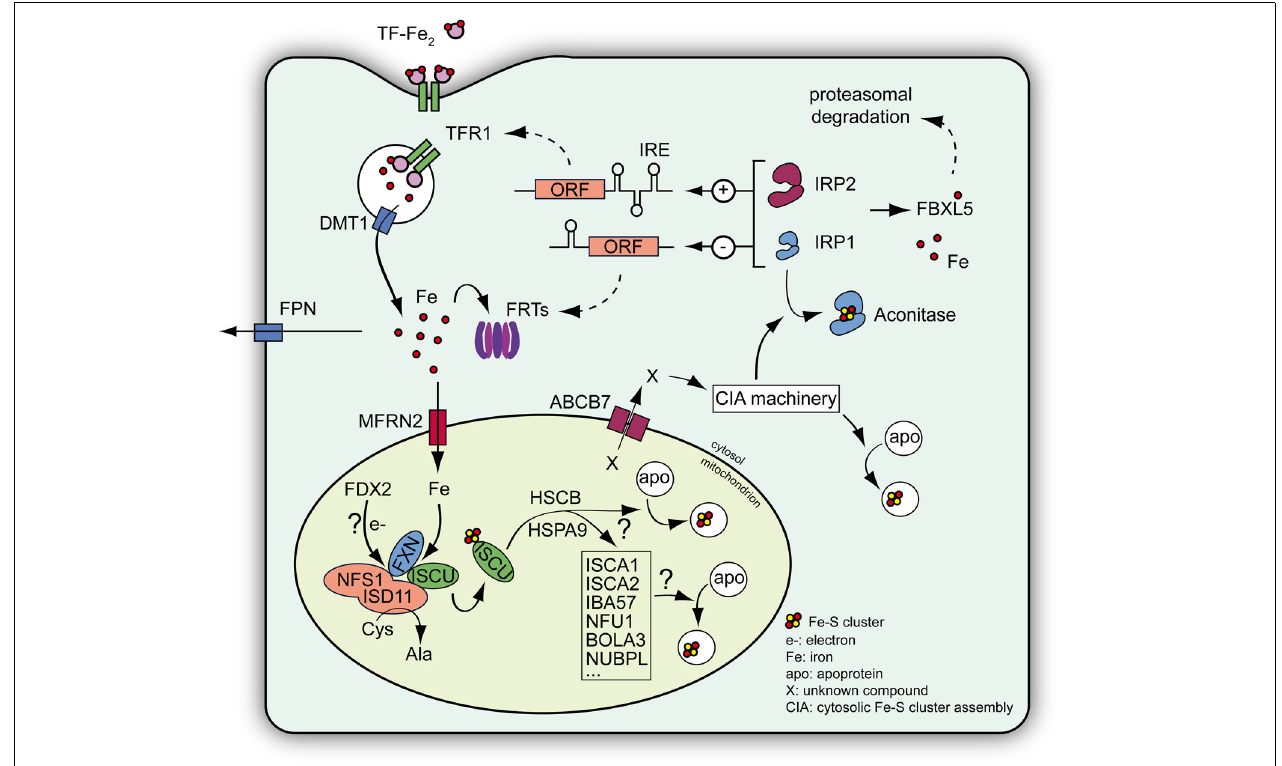
FIGURE 2 | Schematic view of the Fe-S cluster machinery and the IRP-mediated cellular iron regulation. De novo Fe-S cluster biogenesis occurs within mitochondria and involves assembly of inorganic sulfur and iron on a scaffold protein ISCU. Iron is imported into the mitochondria by mitoferrins (MFRN). The process of Fe-S cluster assembly occurs within a complex consisting of NFS1-ISD11, the cysteine desulfurase providing the sulfur, ISCU and eventually frataxin (FXN), which regulates the NFS1 activity and the entry of iron within the complex (Colin et al., 2013). The process also needs electrons (e–) that may be provided by a mitochondrial ferredoxin (FDX2). Once assembled the cluster on ISCU is transferred to acceptor proteins with the help of additional proteins, such as the chaperones HSCB and HSPA9, ISCA proteins, IBA57, NFU1, BOLA3, and NUBPL (reviewed in Lill, 2009; Beilschmidt and Puccio, 2014). Alternatively, a still uncharacterized compound (X) provided by the mitochondrial machinery is exported to the cytosol via ABCB7 and is